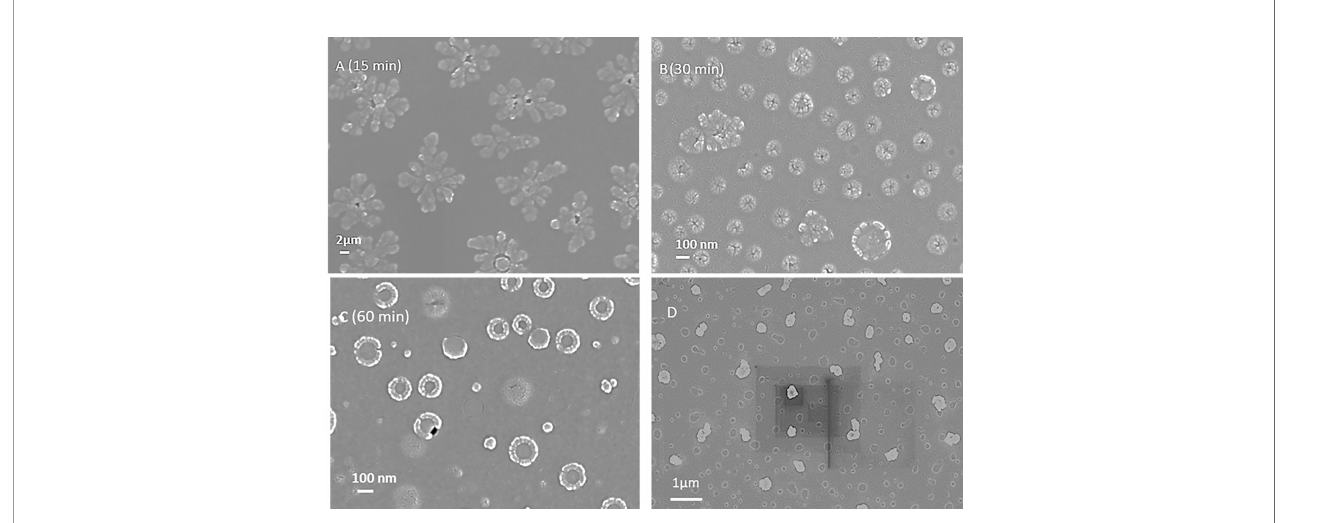
FIGURE 2 | (A-C) Scanning electron microscope images of LbL NP formations at different reaction time (15, 30 and 60 min). 60 min was found to be the optimized time for the core-shell structural nanoparticle formation. (D) SEM image of LbL NP encapsulated with